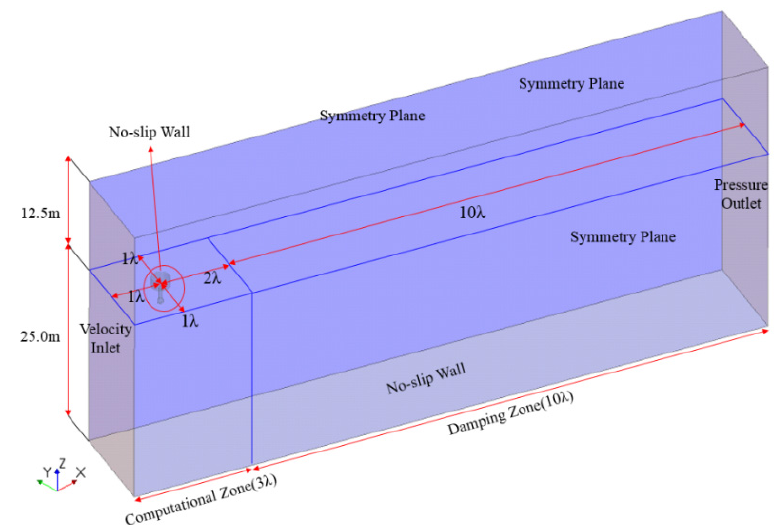
Figure 15. Computational domain and boundary conditions for motion simulations of lightweight light buoys in regular waves using CFD.